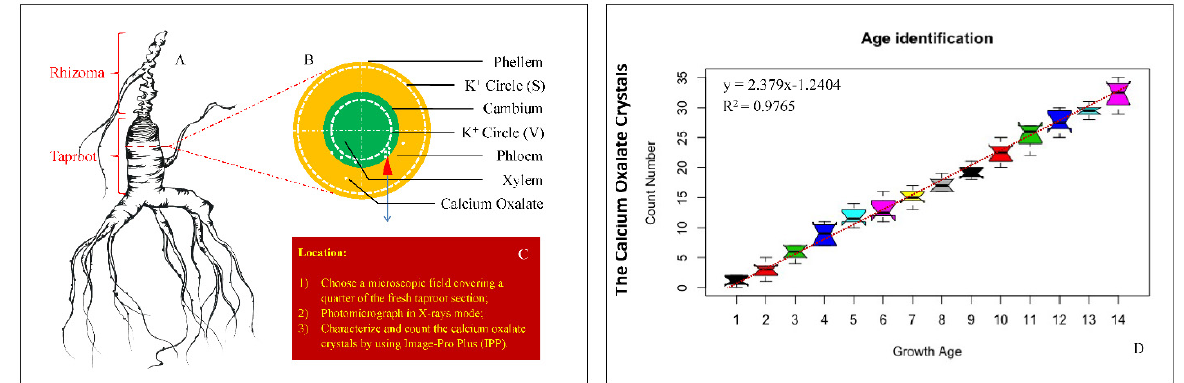
Figure 4. Quantitative counting of the calcium oxalate crystals (COH Crystals) with special micro-positioning and testing the ginseng samples with gradient growth age for acquiring age identification equation. ( A ): Chinese Shizhu ginseng (A farm variety of Panax ginseng ), the ginseng figure was drawn by Dr. Chunsong Cheng ( 程春松 ); ( B ): schematic diagram of positioning for microscopic field observation; ( C ) : important implementation procedures for counting COH Crystals; ( D ): this was an independent result of linear regression, the unary regression equation is the mathematical model used for age identification.